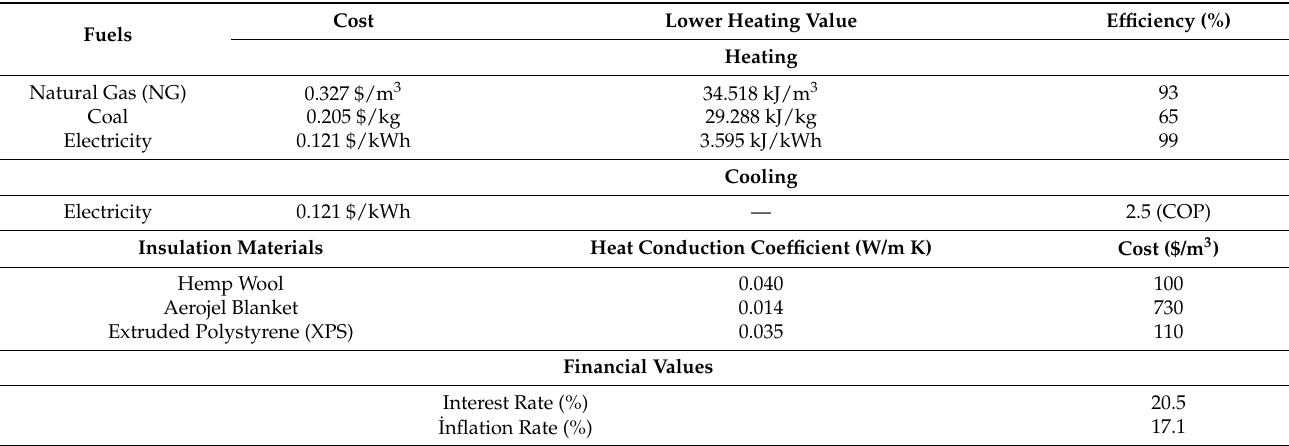
Table 3. The parameters used in cost calculations [3,6,7,9,11,12,29].